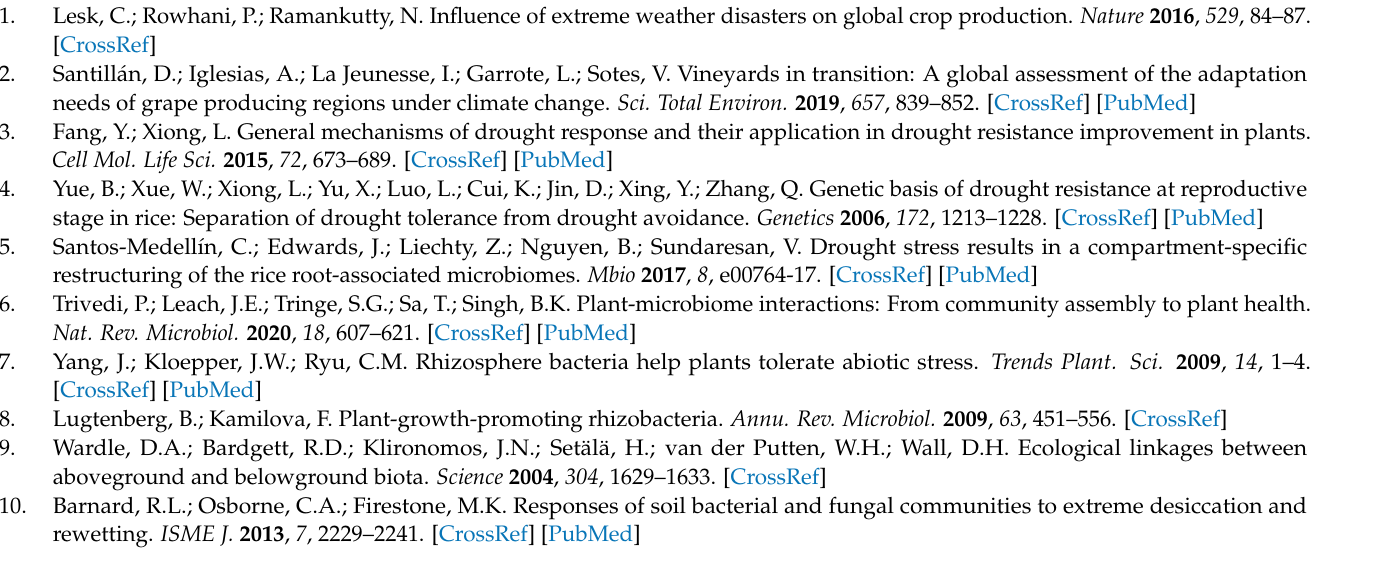
(c) bulk-soil. Figure S9. Relative abundance of the most abundant taxa in (a) root, (b) rhizosphere, and (c) bulk-soil in each watering regime. Figure S10. Bar graph of LEfSe showing the most differentially abundant taxa among the irrigation regimes in each sampling time in (a) root, (b) rhizosphere, and (c) bulk-soil. Table S1: Physicochemical properties of the grapevine nursery soil examined in this study. Table S2: Number of reads, total OTUs and alpha diversity indices. Table S3. Estimates of number of reads, sample coverage, and diversity indices at the genus level for fungal profiles. Table S4. Fungal OTUs that were unique in each irrigation regime in the soil-plant compartments. Table S5. SparCC correlation analysis at genus level in the bulk soil, rhizosphere, and root. Table S6. Relative proportion (%) of fungal function from soil-plant compartments at each irrigation regime inferred by FunGuild. Table S7. Compositions and relative abundance (%) of fungal functional groups (guild) inferred by